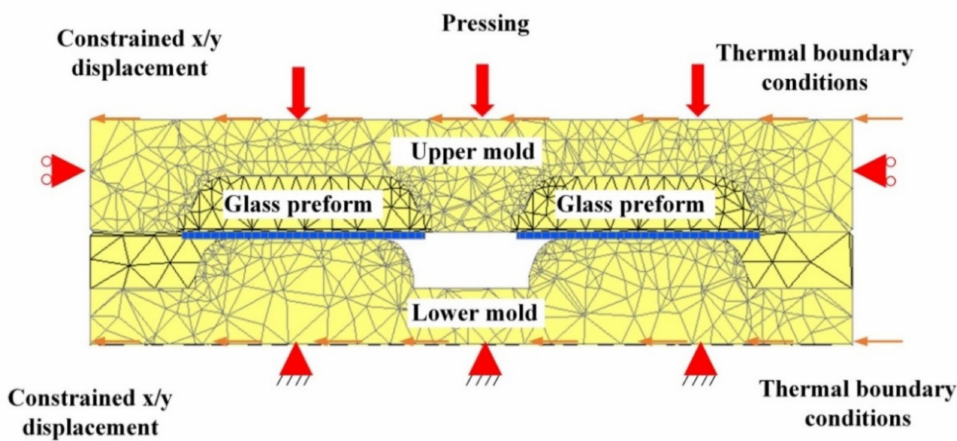
Figure 8. Finite element model and mold of fingerprint lock glass touch